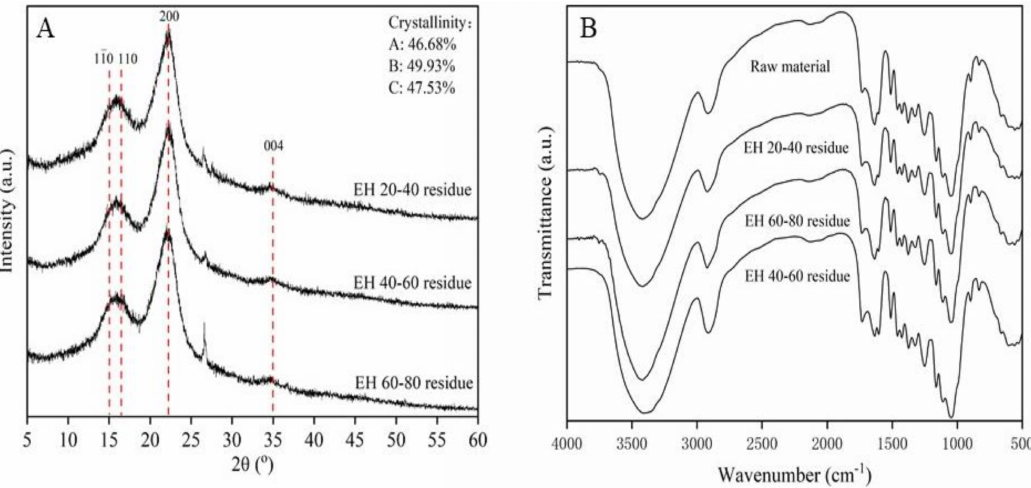
Figure 5. ( A ) XRD patterns and ( B ) FT-IR spectra of mixed corn stalks and sugar cane bagasse samples treated by thread rolling and enzymatic hydrolysis residues (EH means enzymatic